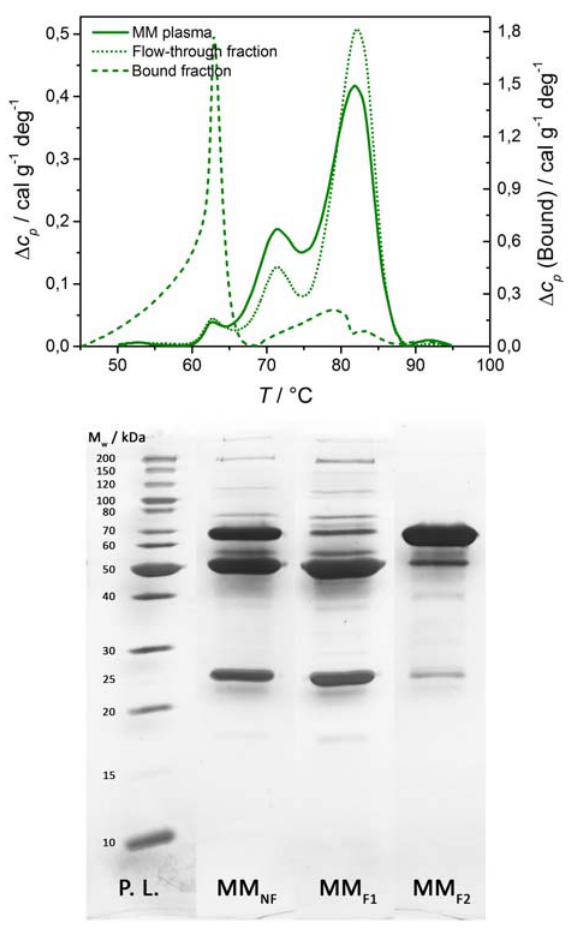
Figure 3. Thermograms of blood plasma from an individual with Figure 4. Thermograms of blood plasma from an individual with AML (top). DSC thermogram of a non-fractionated blood plasma MM (top). DSC thermogram of a non-fractionated blood plasma sample (full line) is compared to thermograms of flow-through sample (full line) is compared to thermograms of flow-through (dotted line) and bound fraction (dashed line) obtained from HPLC (dotted line) and bound fraction (dashed line) obtained from HPLC axis corresponds to the bound fraction. axis corresponds to the bound fraction. fractionation. The right Δ C fractionation. The right Δ C p p SDS-PAGE of blood plasma from an individual with AML (bot- SDS-PAGE of blood plasma from an individual with MM (bottom); tom); P. L. – protein library, AML P. L. – protein library, MM – non-fractionated blood pla- – non-fractionated blood plasma NF NF sma (1 mg/mL), AML – flow-through fraction (1 mg/mL), AML (1 mg/mL), MM – flow-through fraction (1 mg/mL), MM – F1 F2 F1 F2 – bound fraction (0.7 mg/mL). bound fraction (0.5